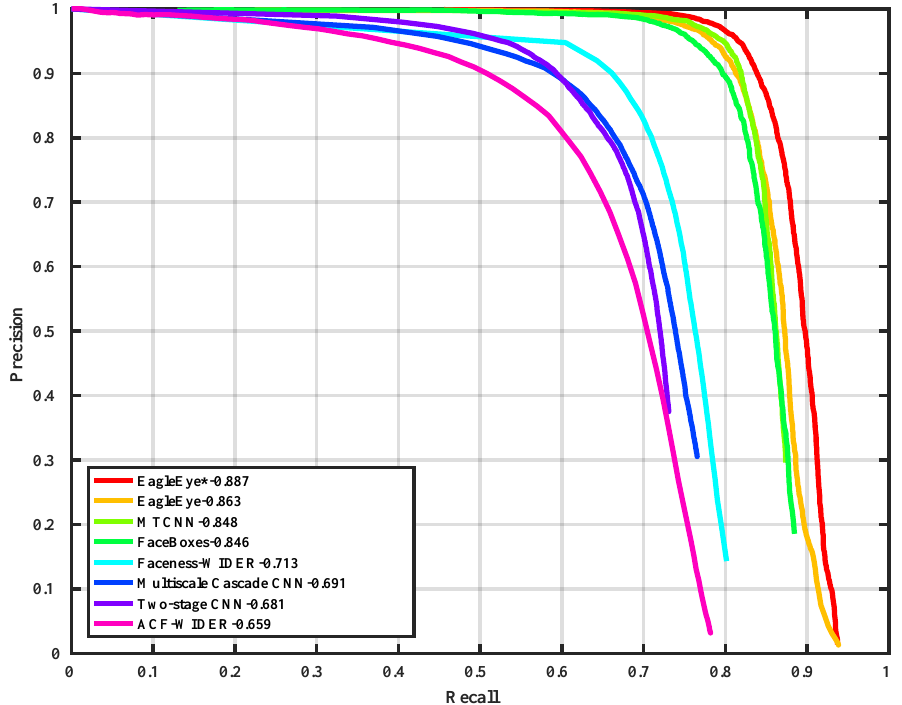
Figure 6. Precision-recall curve on wider face validation (easy) set.